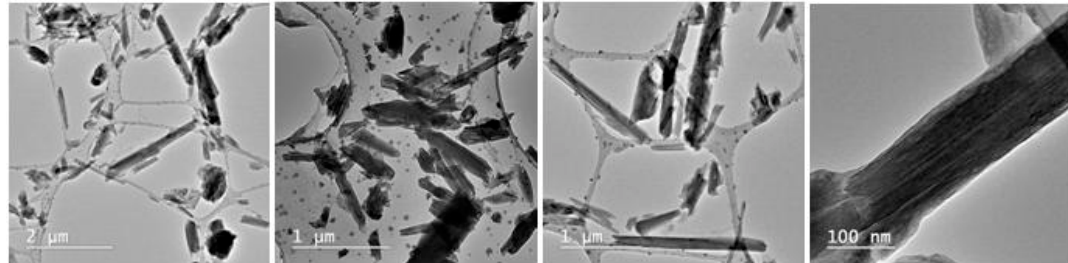
Figure 9. TEM images for HNT particles before modification at different magnifications.